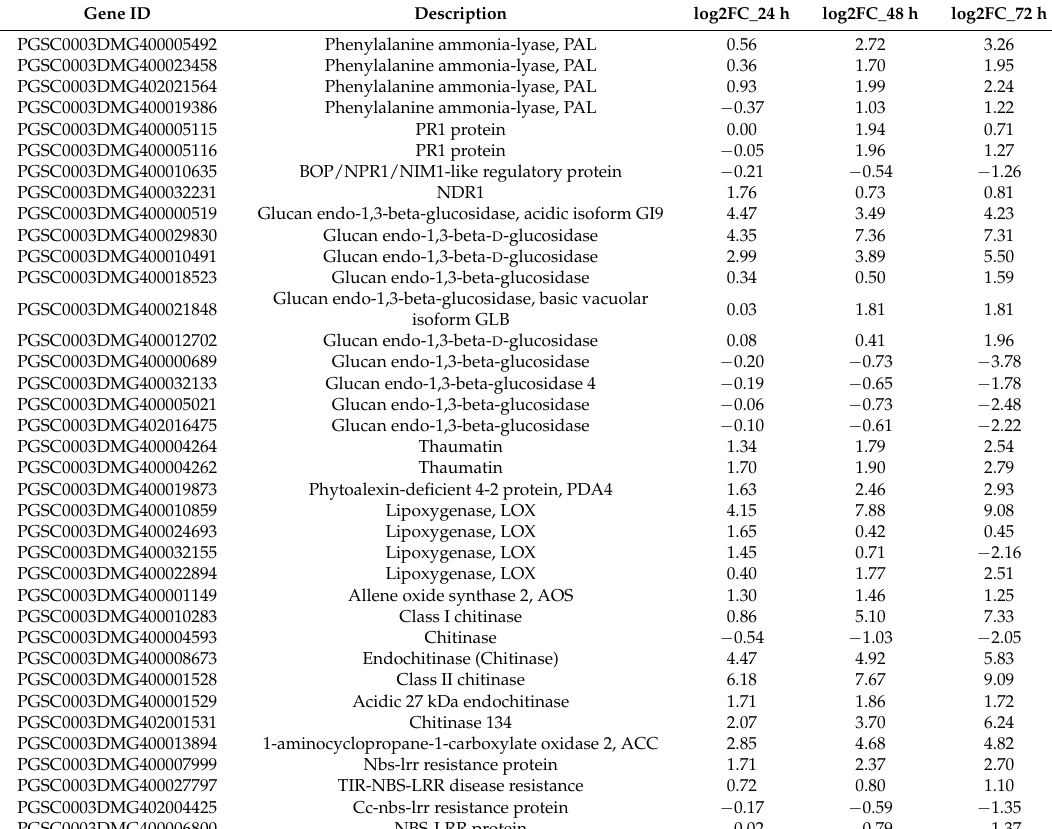
Table 2. The key enzymes and marker genes of SA, JA, and ET signaling pathways. Gene